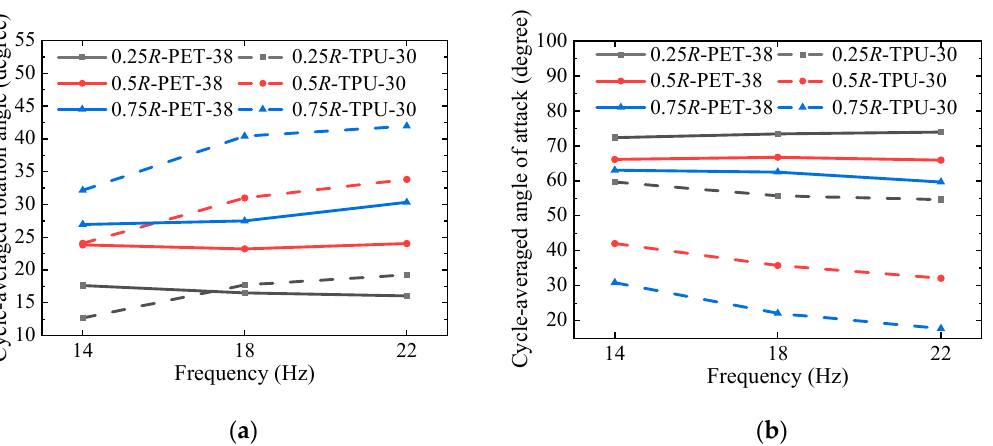
Figure 13. Cycle-averaged angle comparison of PET-38 and TPU-30. ( a ) Cycle-averaged rotation angle; ( b ) Cycle-averaged angle of attack.